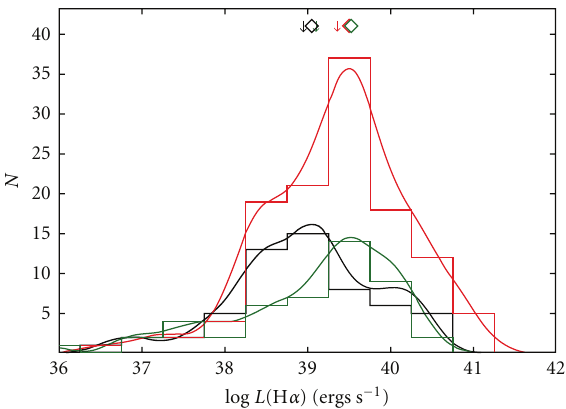
Figure 9: Histogram of H α luminosities (regular and normalized histograms). The black curve is this sample, the red curve is the data from Hunter and Elmegreen for bright dwarf irregulars, and the green curve is the data from Van Zee, a sample of HI-rich dwarf galaxies. Arrows mark the mean value for each sample, and the diamonds mark the median. Our sample is noticeably fainter than Hunter and Elmegreen’s sample primarily due to the nature of their sample selection. Our luminosities are similar to van Zee’s, with a slightly lower mean L (H α ).